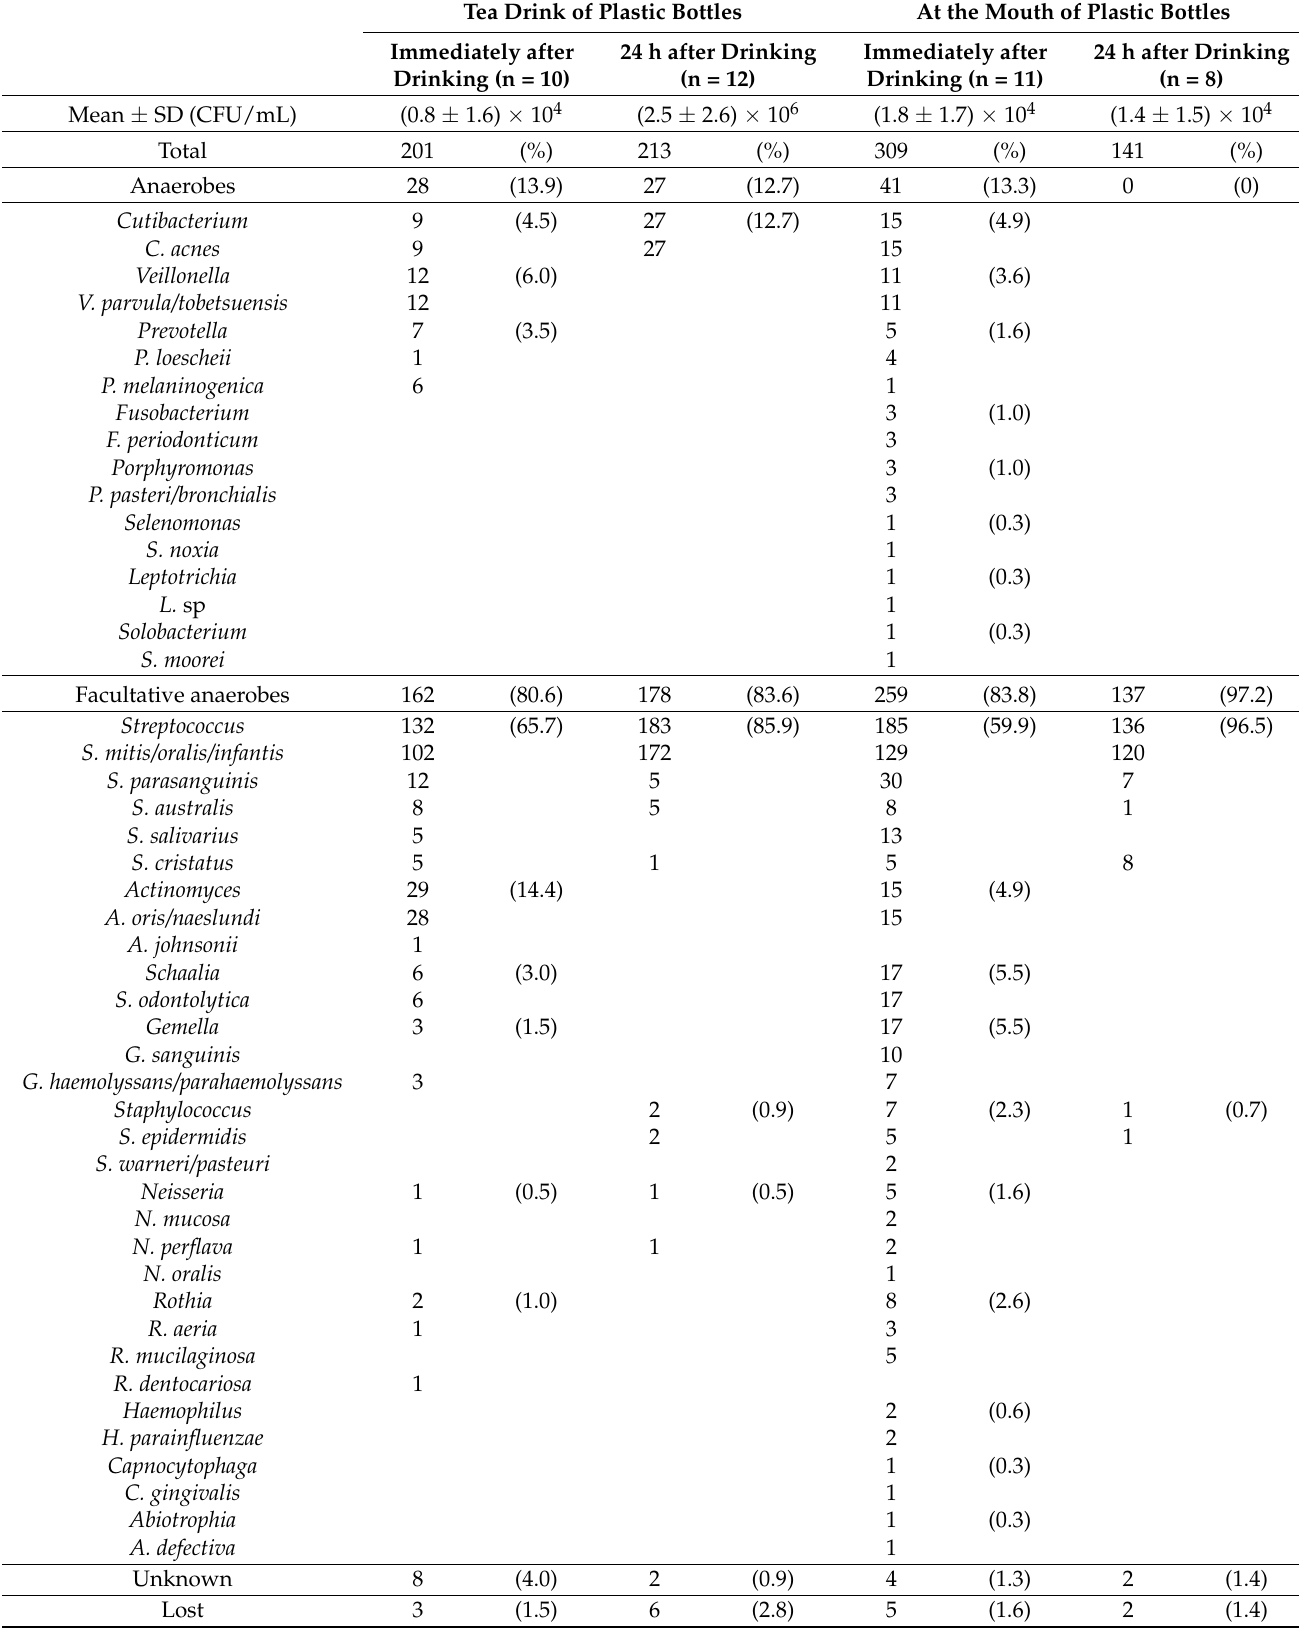
Table 1. Bacteria isolated from plastic bottles of tea immediately after drinking and 24 h after